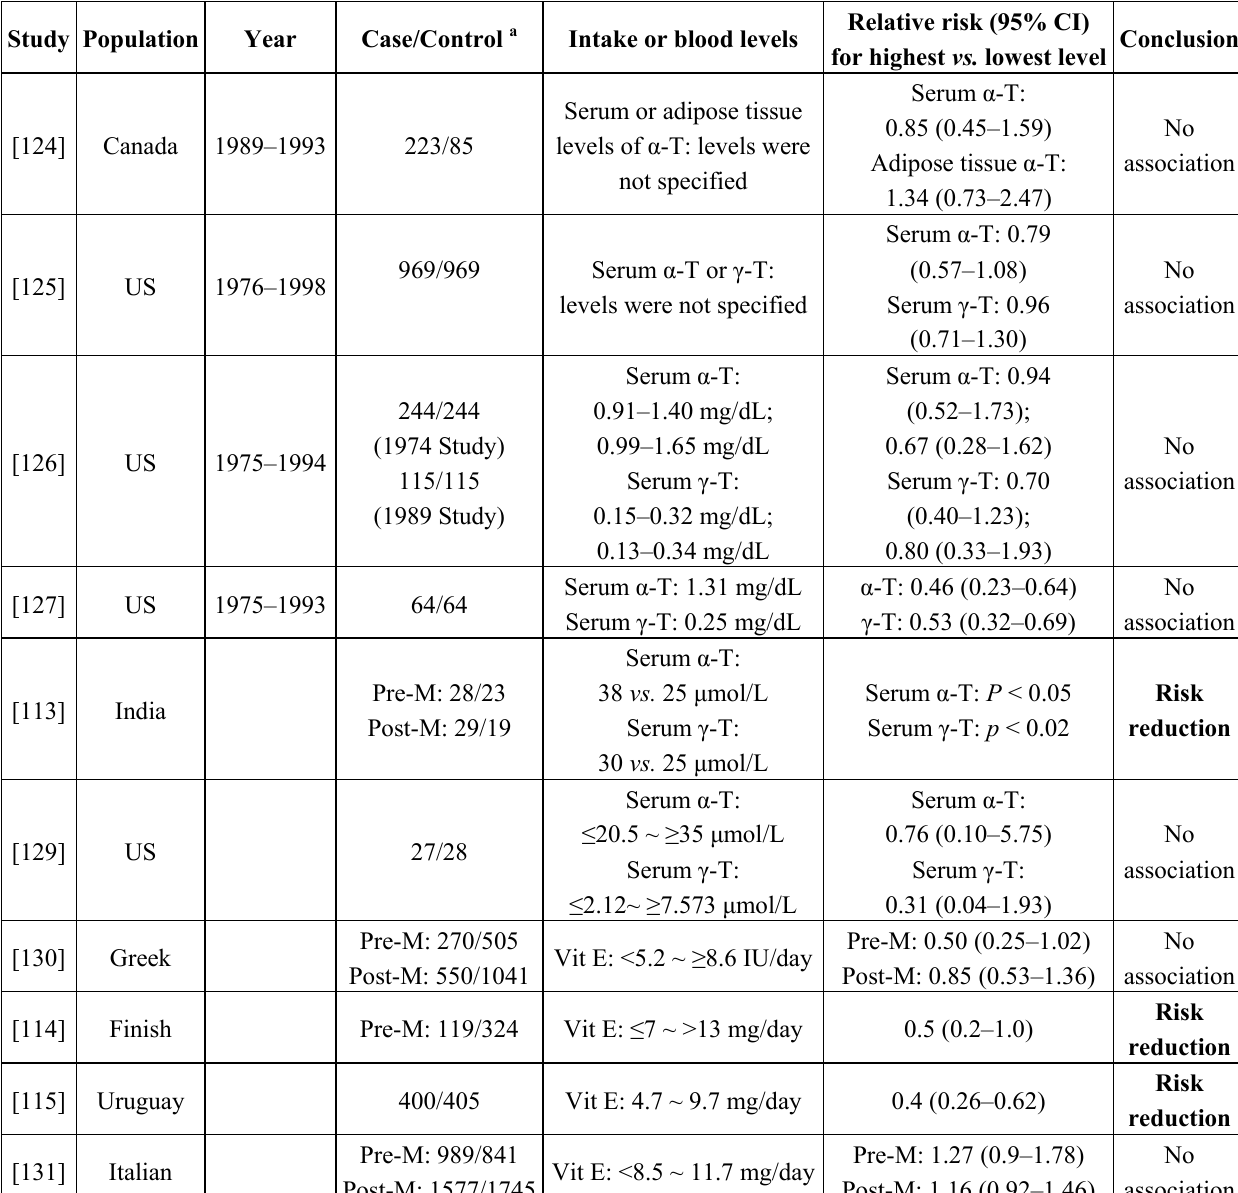
Table 5. Case-control studies of vitamin E and breast cancer